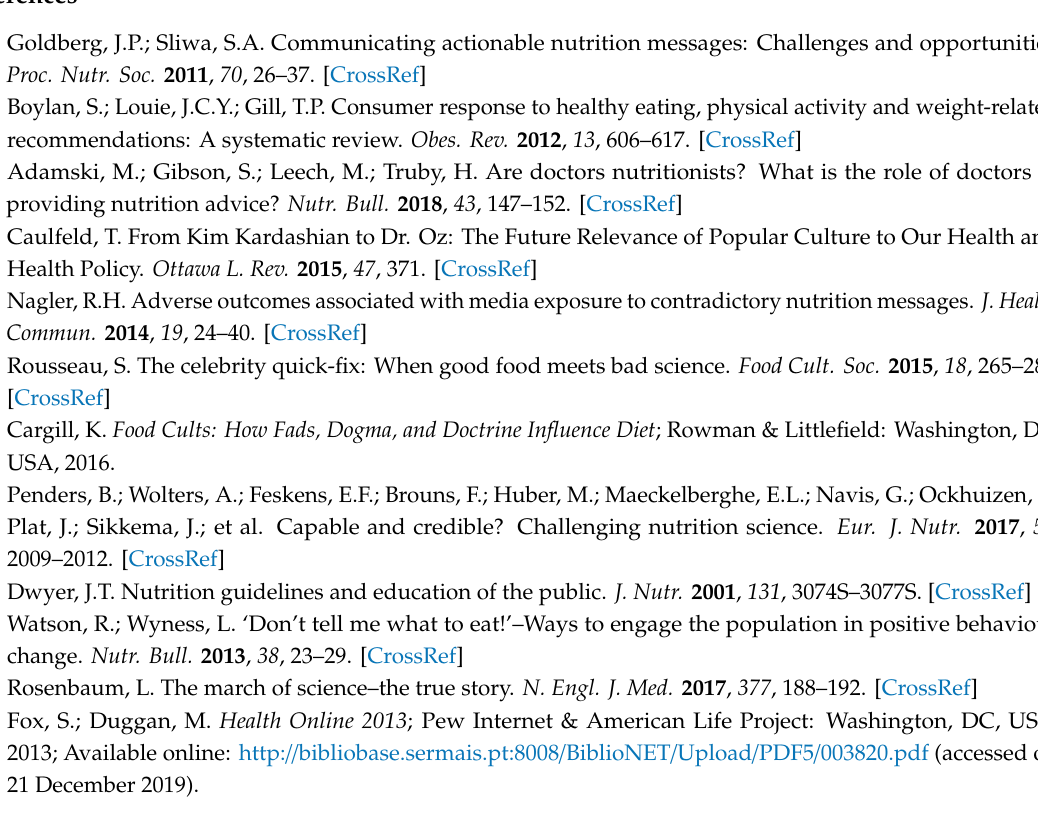
Table S1: Course Outline, Table S2: Qualitative Research Review Guidelines (RATS)